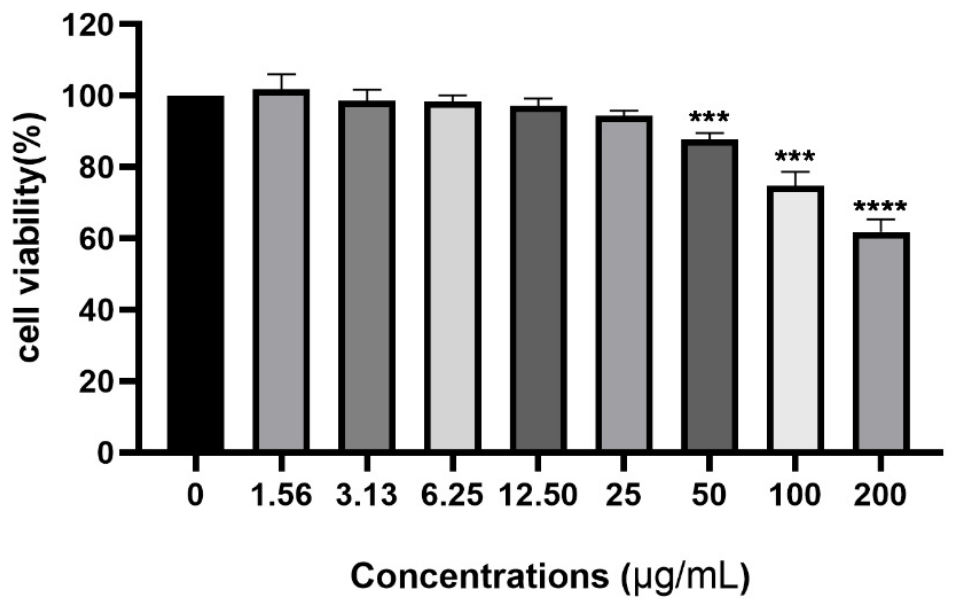
Figure 2. Influence of dictamnine, at concentrations ranging from 0 to 200 µg/mL, on the cell viability (CCK-8 assay) of T24 cells after 24 h incubation. Values represent the mean ± SD from three independent experiments containing 18 technical replicates. *** p < 0.001, **** p < 0.0001.